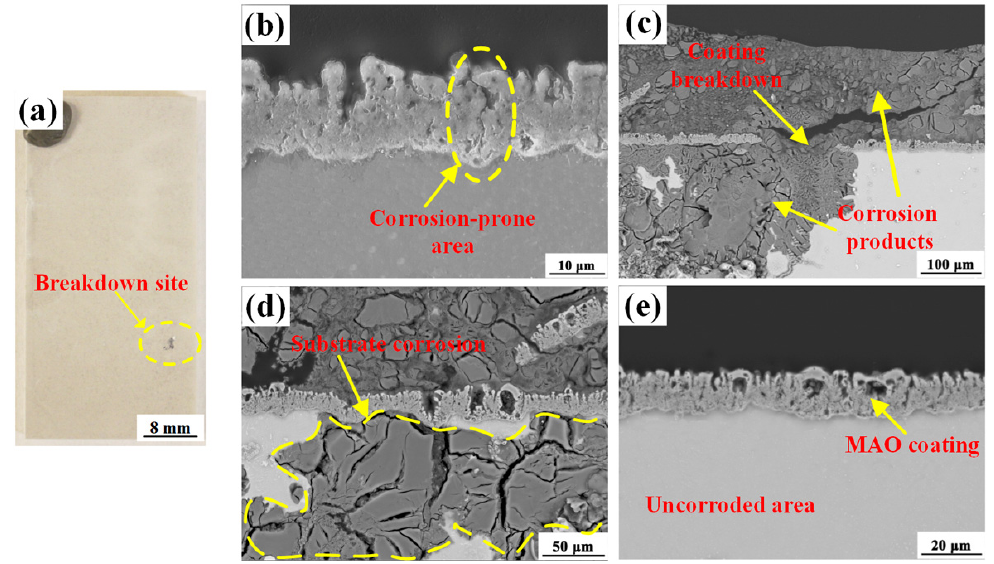
Figure 12. The ( a ) optical image of the breakdown site and SEM cross-sectional images of ( b ) a crack in the coating, ( c ) the breakdown site, ( d ) corroded areas near the breakdown site, and ( e ) uncorroded areas for the MAO-coated ZK60E alloy after 14 days of salt spray test.